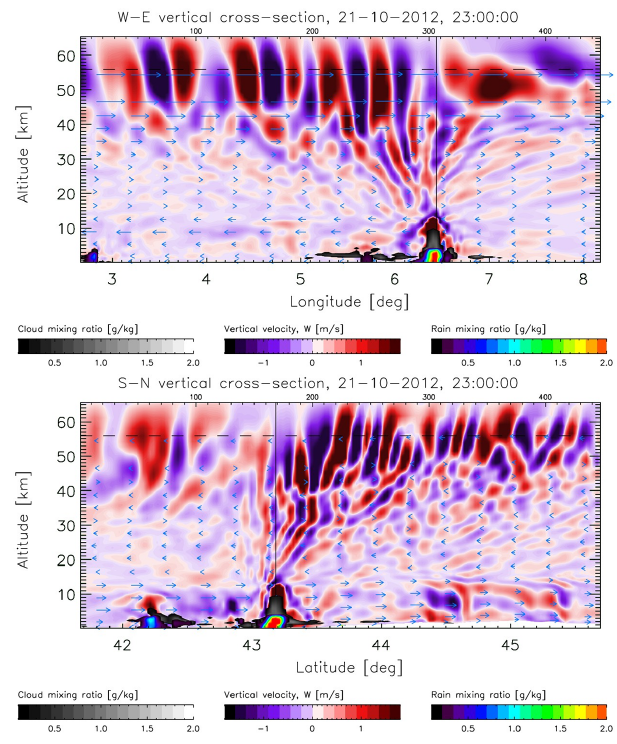
Figure 8. Zonal (top image) and meridional (bottom image) verti- cal cross section of wind vertical velocity, w (ms − 1 ), cloud water mixing ratio (gkg − 1 ) and rain water mixing ratio (gkg − 1 ). Arrow’s length is proportional to the horizontal wind intensity (0.1 ◦ of lati- tude or longitude is equal to 10ms − 1